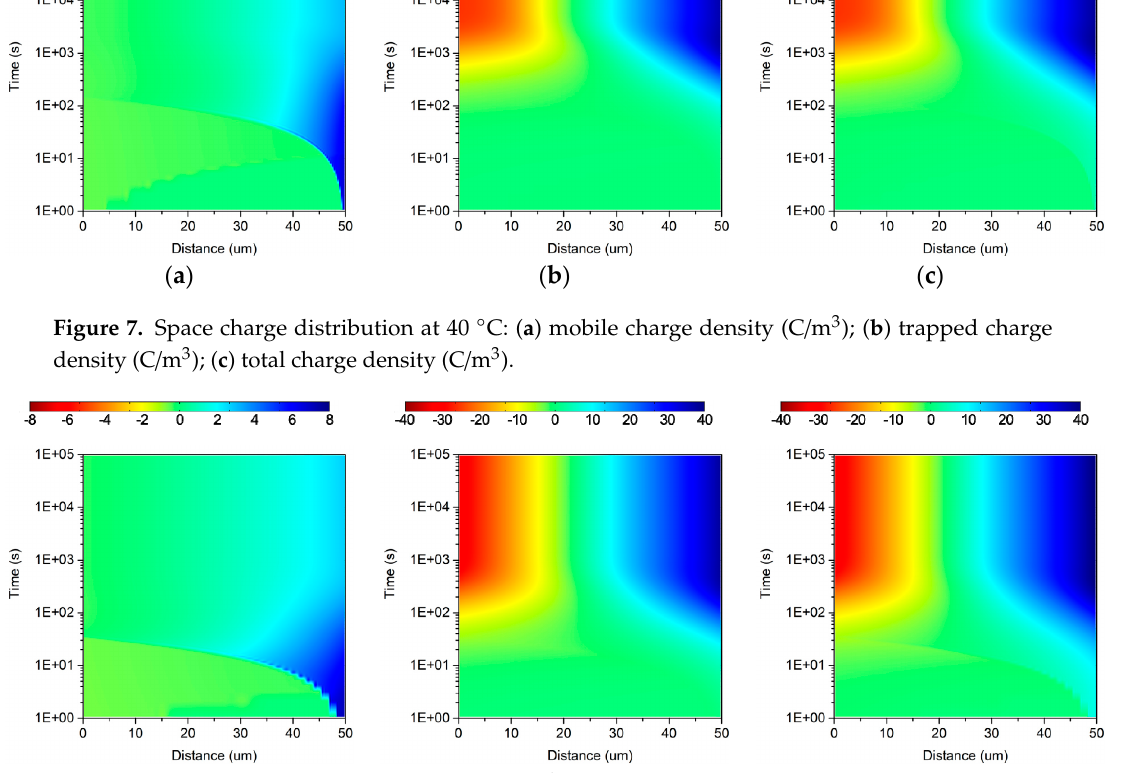
Figure 8. Space charge distribution at 60 °C: ( a ) mobile charge density (C/m 3 ); ( b ) trapped charge density (C/m 3 ); (c) total charge density (C/m 3 ).